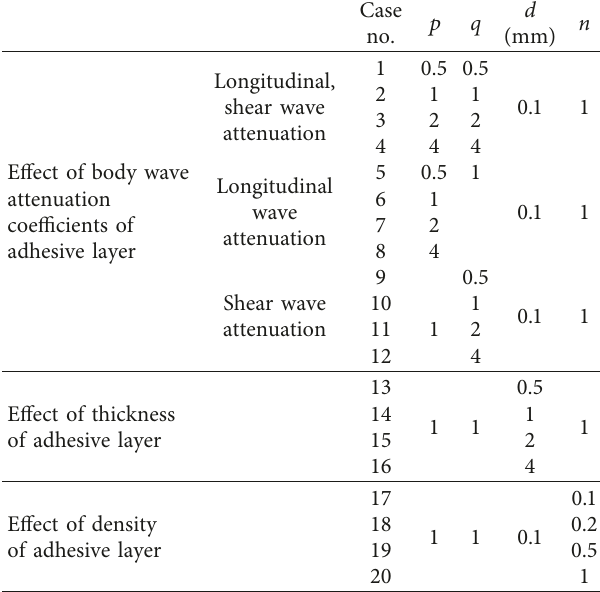
Table 3: Pipe models set for the